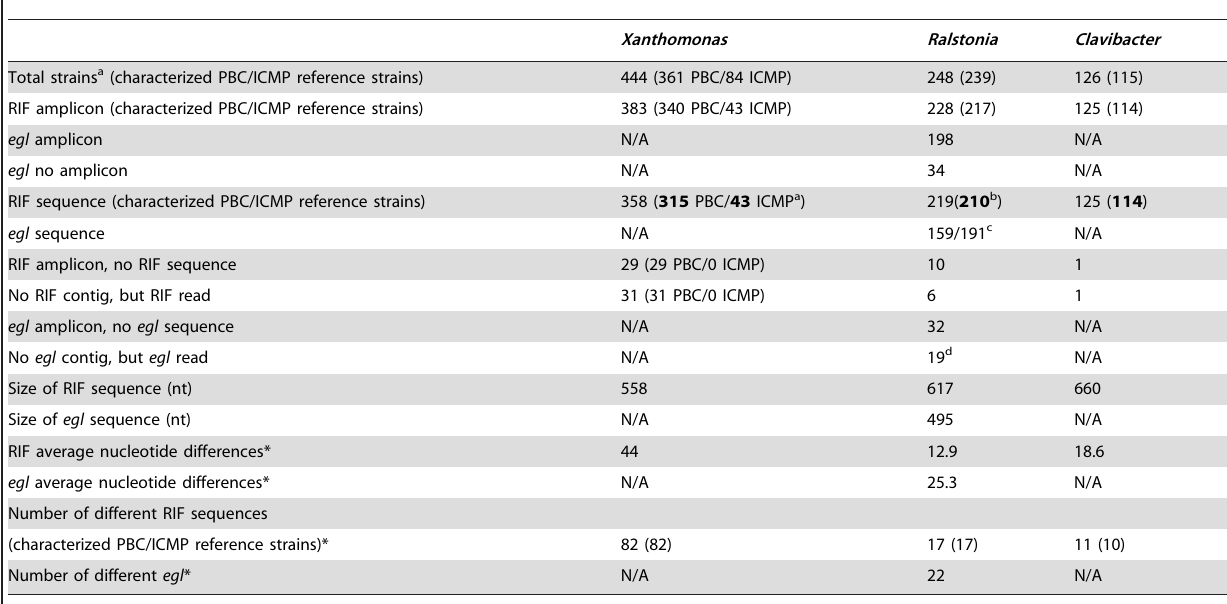
Table 5. RIF sequences for Xanthomonas , Ralstonia and Clavibacter